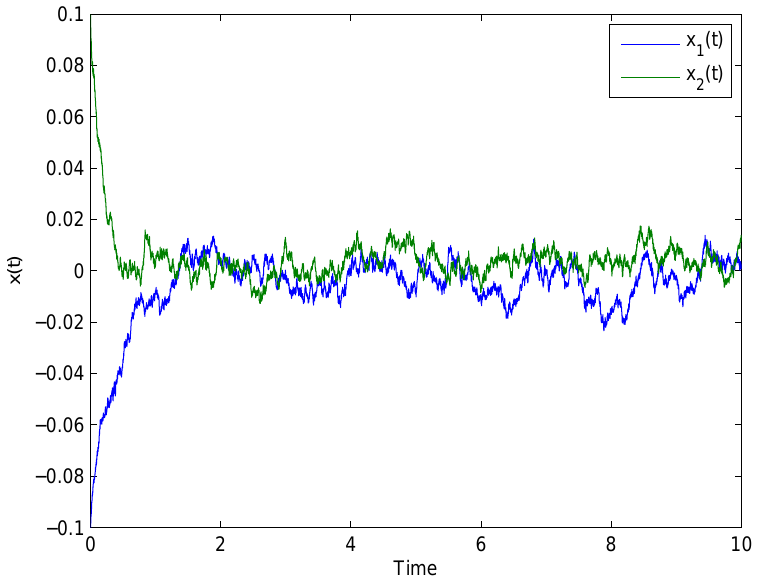
Figure 2. Response solution of the system